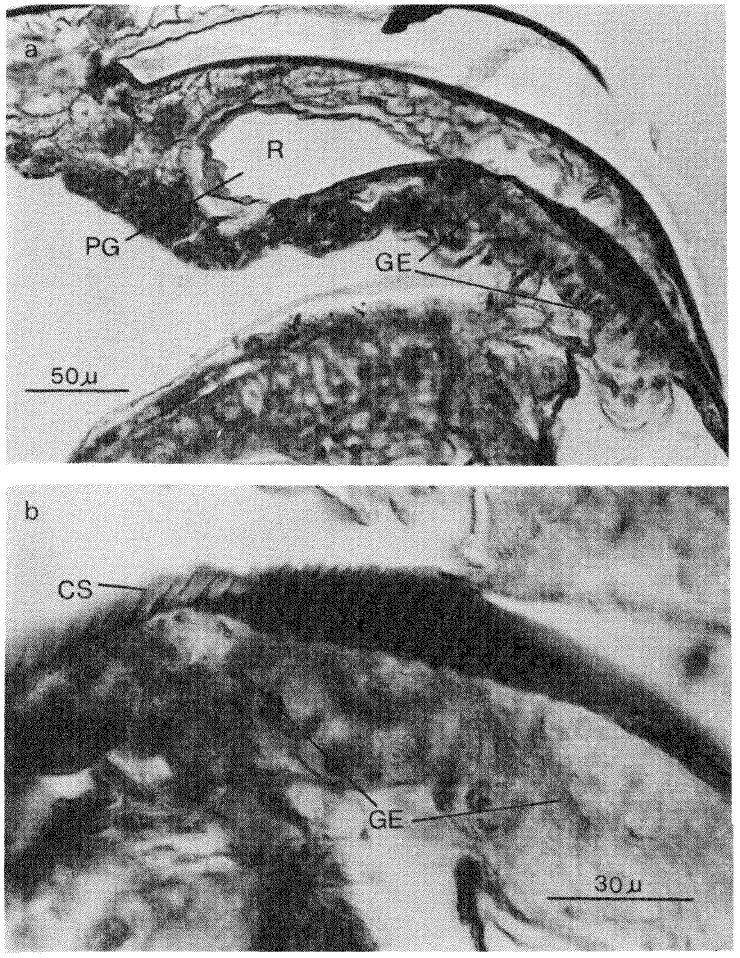
Fig. 4. (a) Sagittal section through pygidial gland of a media of Orectognathus versicolor. PG pygidial gland; R reservoir of pygidial gland; GE glandular epithelium. (b) Close-up of glandular epithelium (GE) under the cuticular structure (CS) of